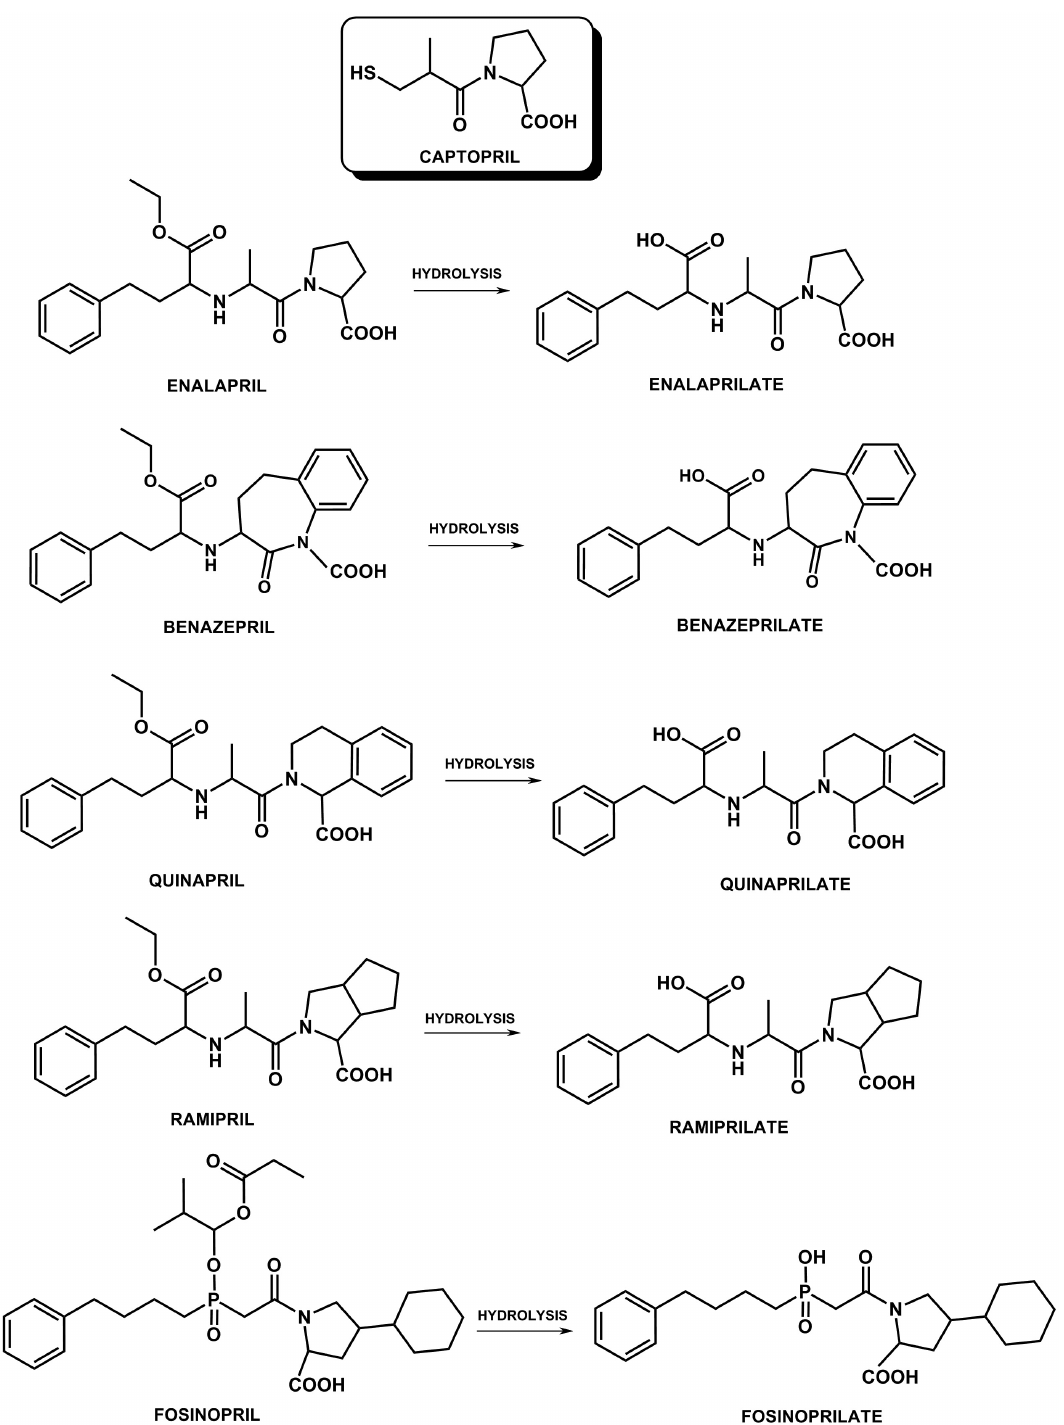
FIGURE 19 - Angiotensin-converting enzyme (ACE) inhibiting prodrugs and their respective hydrolyses to their active forms venezuelae . This compound was the first antibiotic effec- tive against a wide variety of microorganisms to be used particularly in the treatment of serious infections such as typhoid fever and other forms of salmonellosis, Haemo- philus Influenza infections , especially of the meninges,